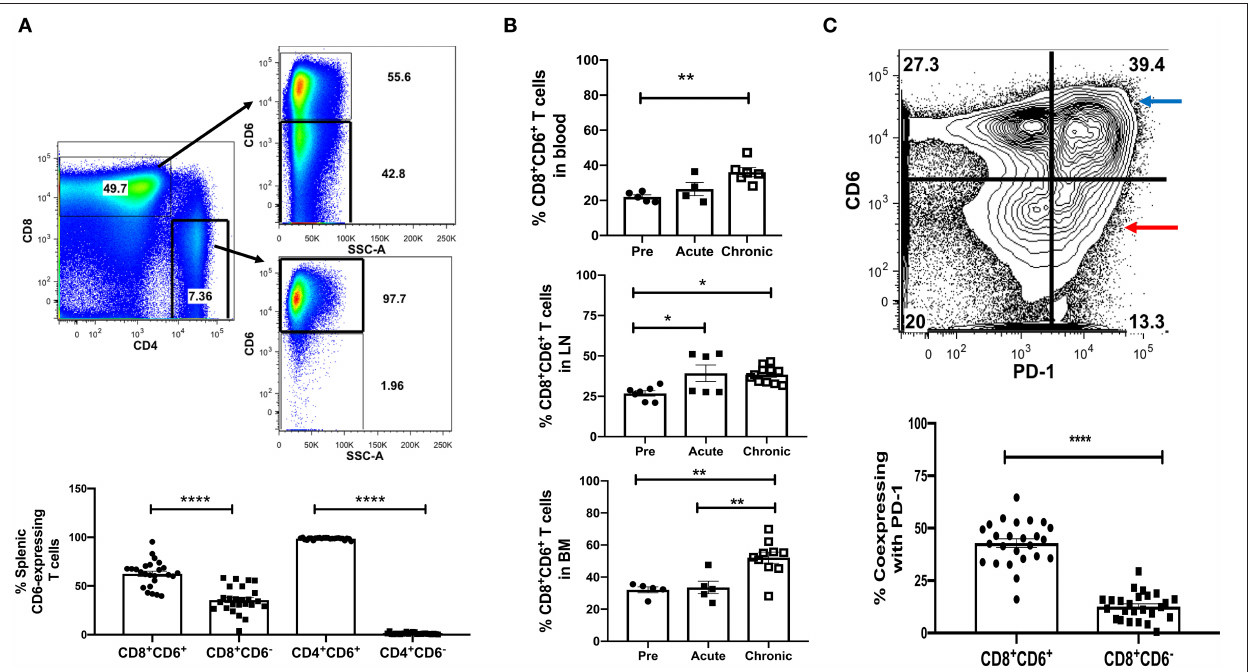
FIGURE 1 | Characterization of CD6 and PD-1 expression on CD8 + T-cells in different tissue compartments of chronically SIV-infected macaques. (A) Flow cytometry gating strategy for CD6 expression on CD8 + and CD4 + T-cells in the spleen during chronic infection (top panels) and frequencies of CD8 + and CD4 + T-cells expressing CD6 (bottom panel). Data are from 27 macaques. (B) The frequency of CD8 + CD6 + T-cells in the blood (top row), LN (middle row), and bone marrow (bottom row) at different time points following SIV infection. Data for the blood are from 4 to 6 macaques, data for the LN are from 7 to 11 macaques, data for the bone marrow are from 5 to 10 macaques. (C) Representative staining for CD6 and PD-1 co-expression on splenic CD8 + T-cells during chronic SIV infection (top panels) and frequencies of CD8 + CD6 + and CD8 + CD6 − cells co-expressing PD-1 (bottom panel). Red arrow indicates CD8 + CD6 + PD-1 + cells, whereas blue arrow indicates CD8 + CD6 − PD-1 + cells. Data are from 25 macaques. Data are shown as means ± SEM. For statistical analysis, nonparametric Mann-Whitney tests were performed * p < 0.05, ** p < 0.01, **** p < 0.0001.